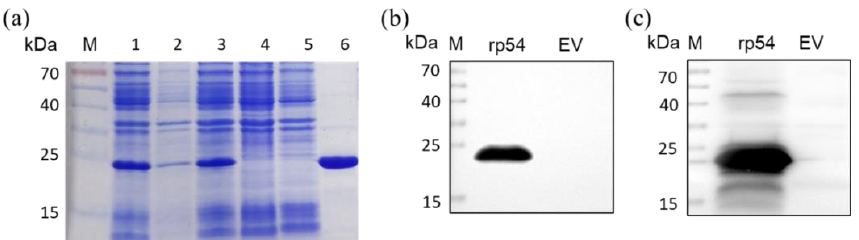
Figure 2. Analysis of rp54 protein. ( a ). SDS − PAGE analysis of His − tagged rp54 protein expression, followed by Coomassie brilliant blue stain. M is protein ladder, lane 1 was supernatants of bacterial cell lysates after induction with IPTG, lane 2 was precipitates of bacterial cell lysates after induction with IPTG, lane 3 was whole bacterial cell lysates after induction with IPTG, lane 4 was whole bacterial cell lysates with no induction with IPTG, lane 5 was negative control with pET-28a vector, lane 6 was the purified rp54 protein. ( b ). Western blot analysis of rp54 protein with anti − His tag antibody. ( c ). Western blot analysis of rp54 protein with ASFV − positive serum.